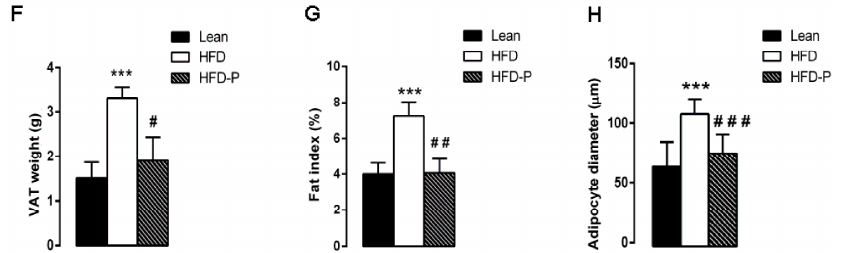
Figure 7. Pistachio consumption reduces visceral fat accumulation. Transverse micro-CT images of the abdomen ( A ) and visceral adipose tissue (VAT) and subcutaneous adipose tissue (SAT) volumes ( B ) in lean, HFD, and HFD-P mice belonging to reversal protocol. Histological cross-sections of VAT from lean ( C ), HFD ( D ), and HFD-P mice ( E ). Hematoxylin and eosin stain. Original magnification: × 200. VAT weight ( F ), VAT weight normalized to body weight (fat index) ( G ), and adipocyte diameter ( H ) in lean, HFD, and HFD-P mice. Data are the means ± S.E.M. ( n = 8/group). Asterisk denotes significant difference compared with the lean group (* p < 0.05; ** p < 0.01; *** p < 0.001); hash denotes significant difference compared with the HFD group ( # p < 0.05; ## p < 0.01; ### p < 0.001). The analysis of gene expression revealed that HFD-P significantly reduced FAT-P and SCD1 expression in liver and SREBP - 1c , FAS , and SCD1 expression in adipose tissue (Figure 8 A–D).